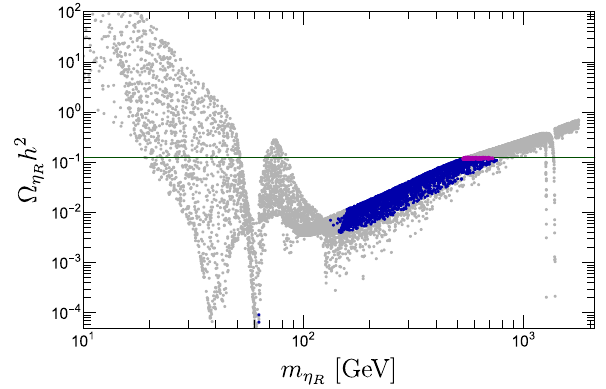
Fig. 2 Relic abundance of η R as a function of m η depict solutions in agreement with the cold dark matter measurement obtained from Planck data [44] (green band, 3 σ interval). Blue points denoteallowedsolutionsbutleadingtounderabundantdarkmatter.Gray points are excluded by any of the constraints listed in Sect. 3